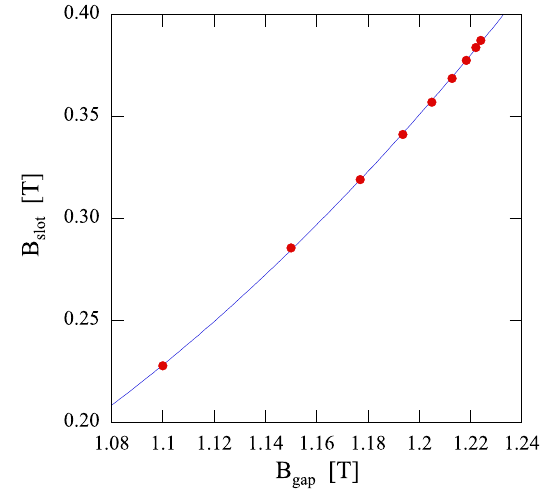
FIG. 9. Correlation between field strengths at the pole gap and return-yoke